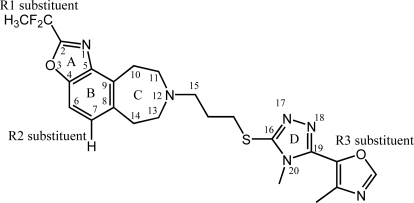
The structure of compound 9 [11]. R1, R2 and R3 substituents are –CF2CH3, H and
, respectively.